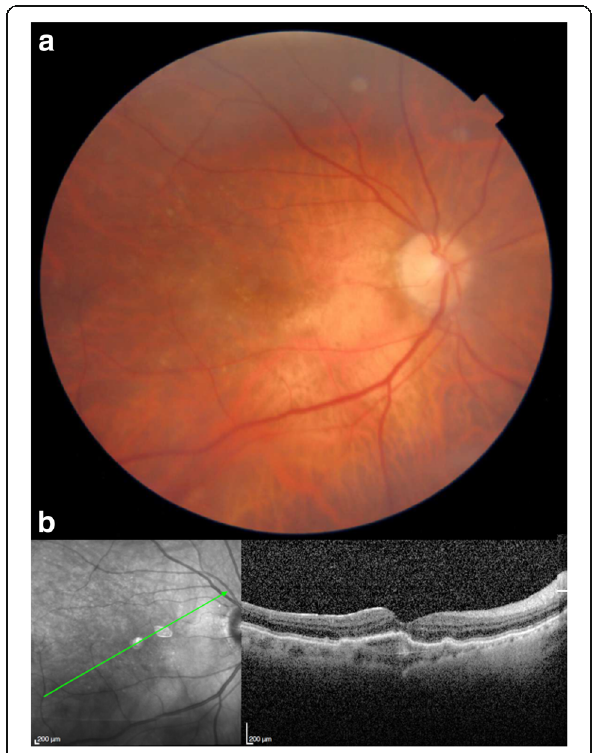
Fig. 4 Patient 1. a Color retinography showing drusen and b OCT showing fibrovascular pigment epithelium detachment with resolution of subretinal and intraretinal